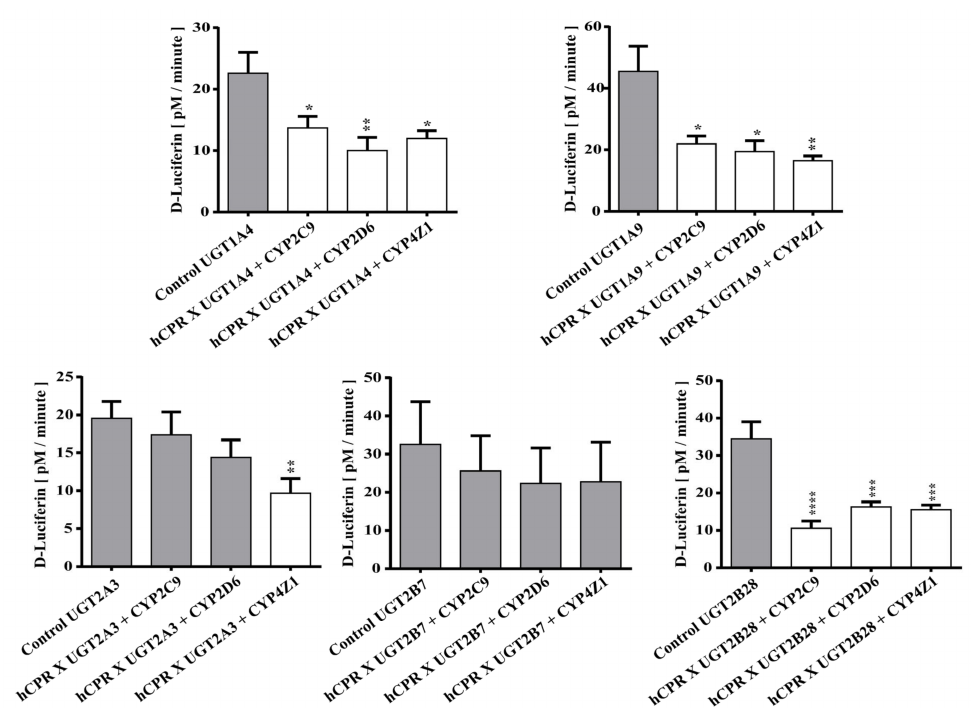
Figure 5. Enzymatic activities of enzyme bags prepared from diploid strains co-expressing five differ- ent UGTs with CPR and four different CYPs as indicated. Activities towards UGT-Glo substrate A are shown in comparison to the respective control strains (which only express one of the UGTs). Activities that are not different from the control are shown in grey, while those that are statistically significantly lower than the control are shown in white. * p < 0.05, ** p < 0.01, *** p < 0.005, **** p <